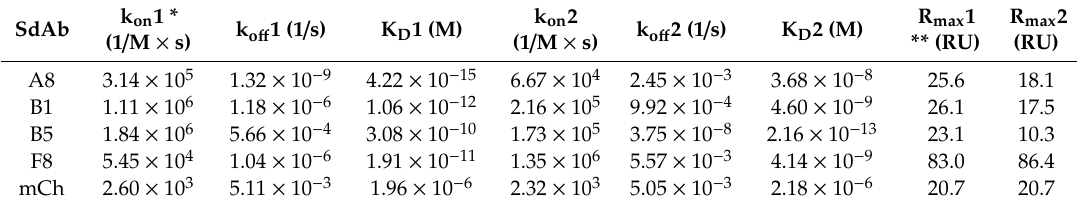
Table 1. Surface plasmon resonance spectroscopic determination of sdAb binding a ffi nities to FGFR4.